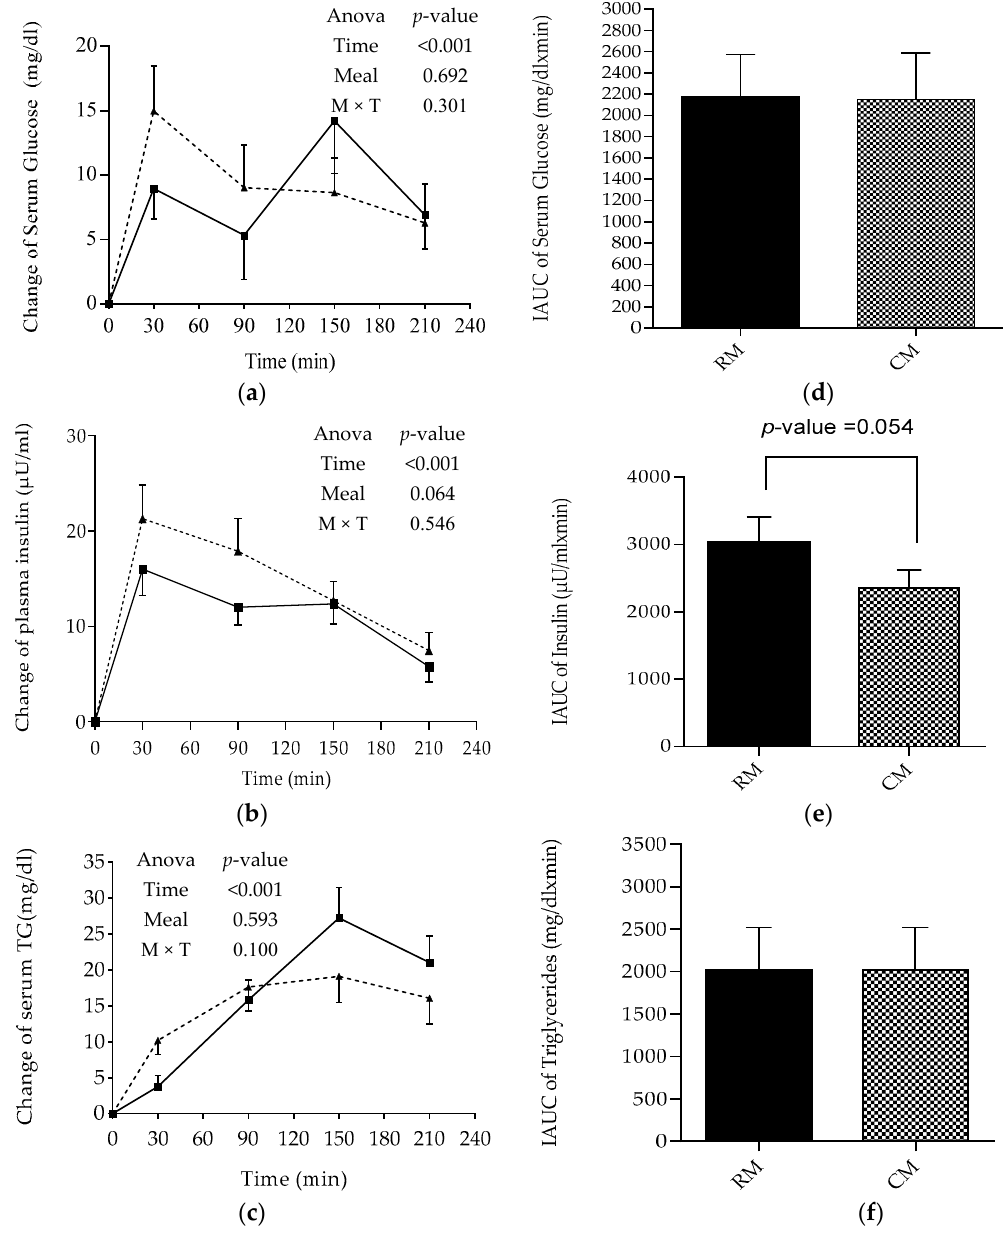
Figure 2. Postprandial changes in glucose ( a ), insulin ( b ) and TG ( c ) from baseline following the ingestion of RM and CM meals. Bars are the incremental areas under the curve (IAUC) of the changes in serum glucose ( d ), insulin ( e ) and triglycerides (TG) ( f ). Data are expressed as mean values ±